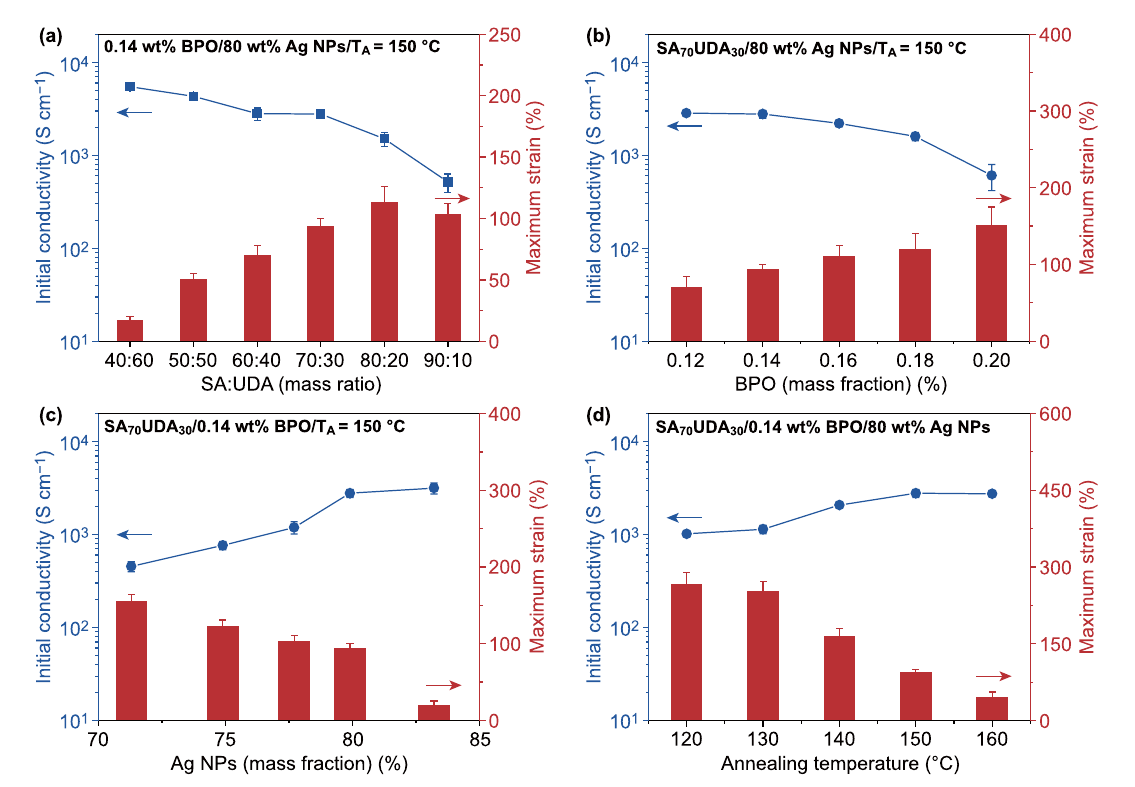
Fig. 2 Effects of four parameters on initial conductivity and maximum strain of SMSC tape at 60 ℃ . a The mass ratio between SA and UDA. b The content of BPO. c The content of Ag NPs. d Annealing